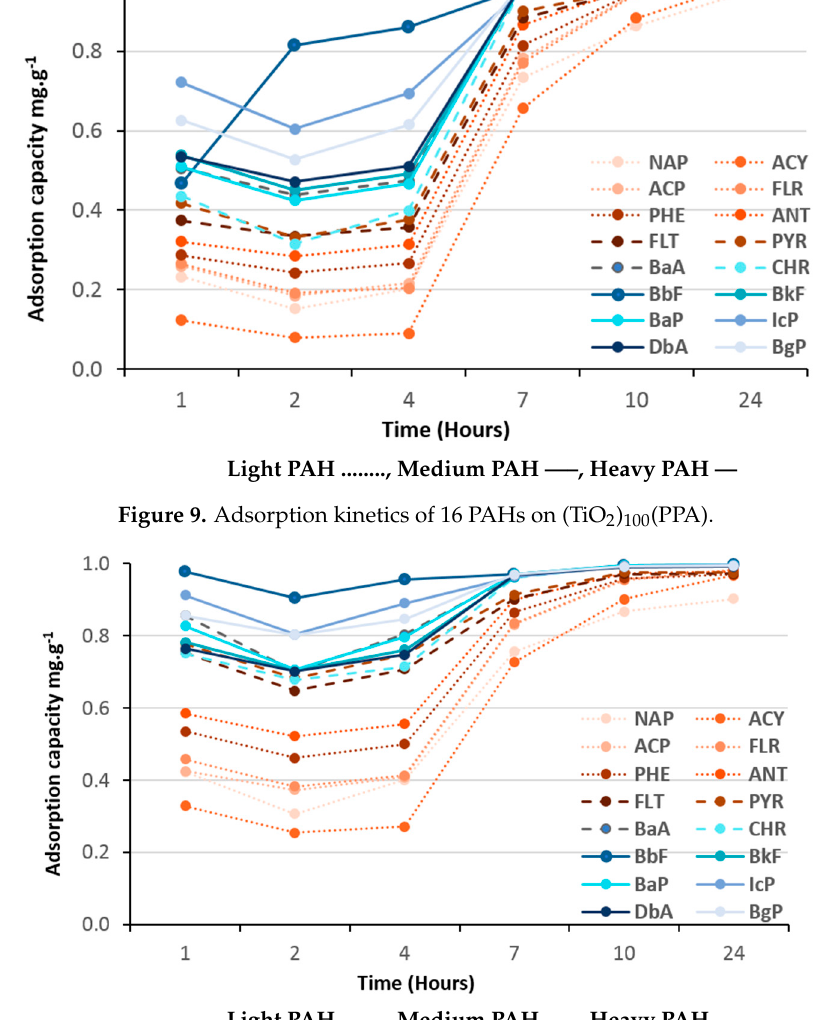
Figure 8. Adsorption kinetics of 16 PAHs on (TiO 2 ) 100 (VPA).